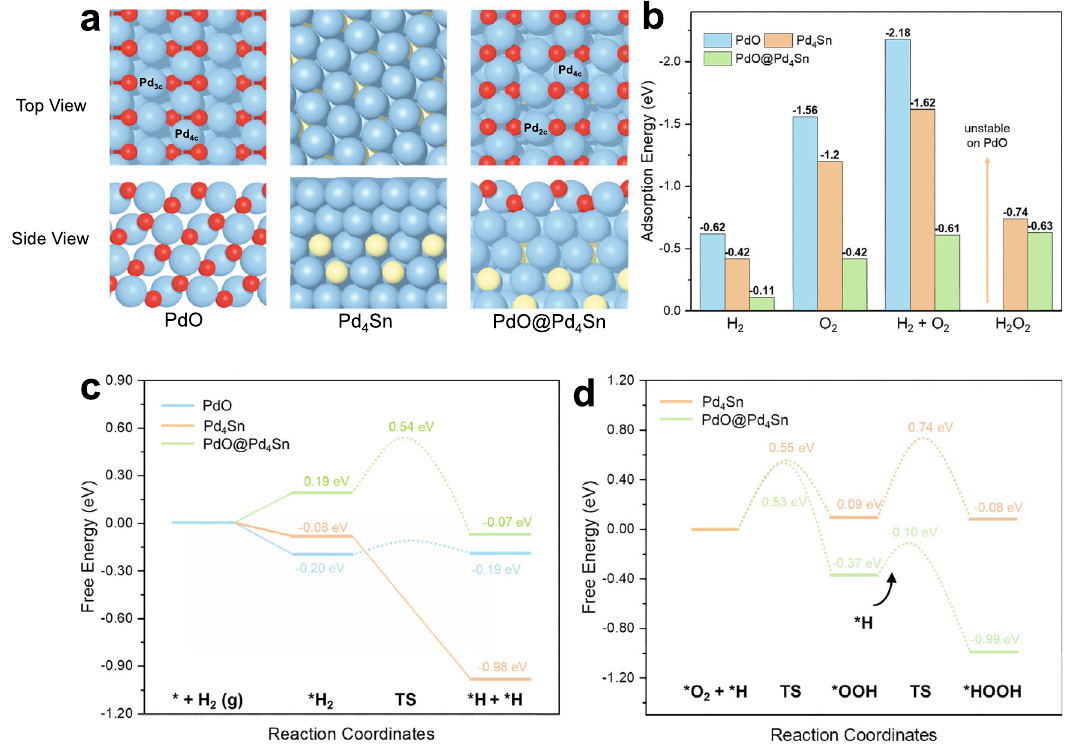
d free energy pro fi les for O 2 reduction by the surface hydrides on these three models. TS transition state. Color code: Pd, blue; O, red; H, white; Sn,